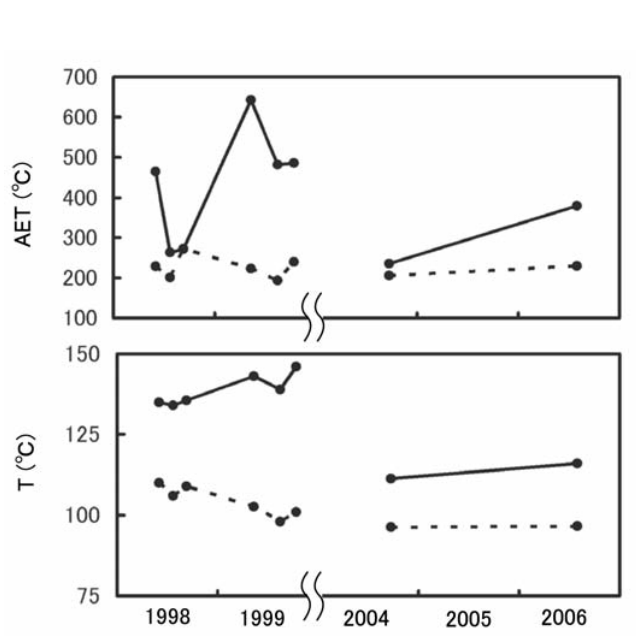
Figure 8. Temporal variations in the apparent equilibrium temperature (AET) calculated for the chemical compositions of the JA (solid lines) and JB (dashed lines) series (upper), and for the outlet temperatures of the gases